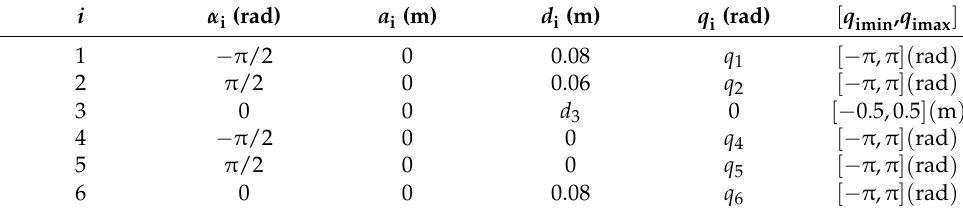
Table 1. Standard DH parameters of the Stanford